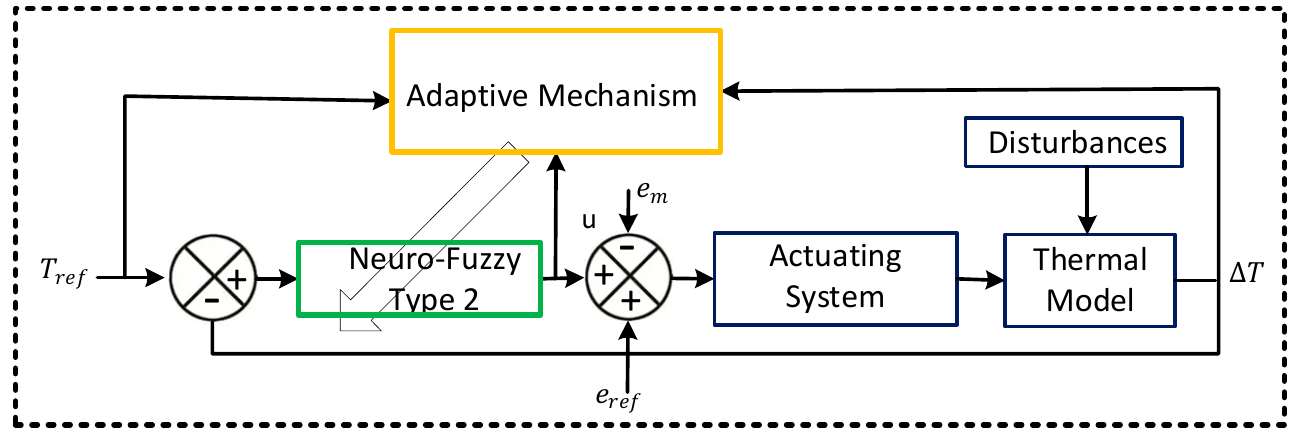
Figure 4. The closed-loop control structure for adaptive Neuro-Fuzzy Type-II.